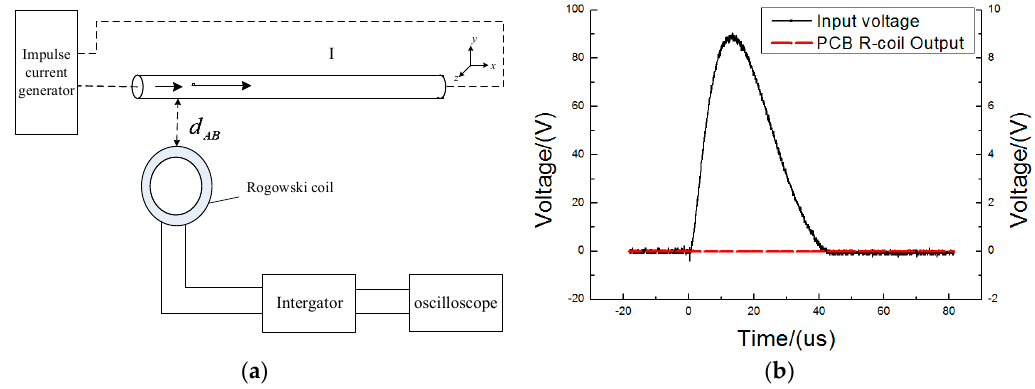
11 of 16 Figure 12. Linearity test fitting curve. 5.2. Test of Adjacent Wire Interference The output line of the impulse current generator was extended to simulate the effect of adjacent